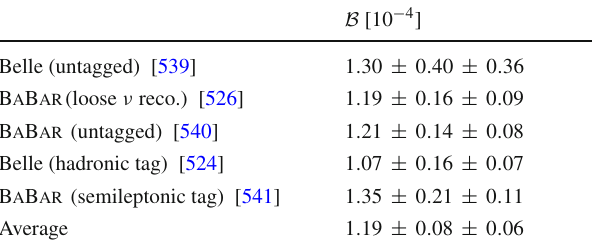
Table 86 Summary of exclusive determinations of B + → ω(cid:12) + ν . The errors quoted correspond to statistical and systematic uncertainties, respectively